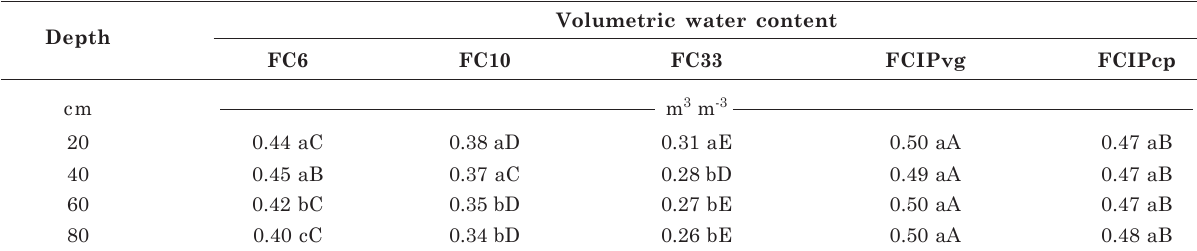
Means followed by same lower case letter in the column and upper case letter in the row do not differ by the Scott-Knott test at 5 %. Coefficient of variation = 3.0 %. FC6: θ corresponds to -6 kPa; FC10: θ at -10 kPa; FC33: θ to -33 kPa; FCIPvg: θ corresponds to h obtained by the van Genuchten model; FCIPcp: θ corresponds to h IP